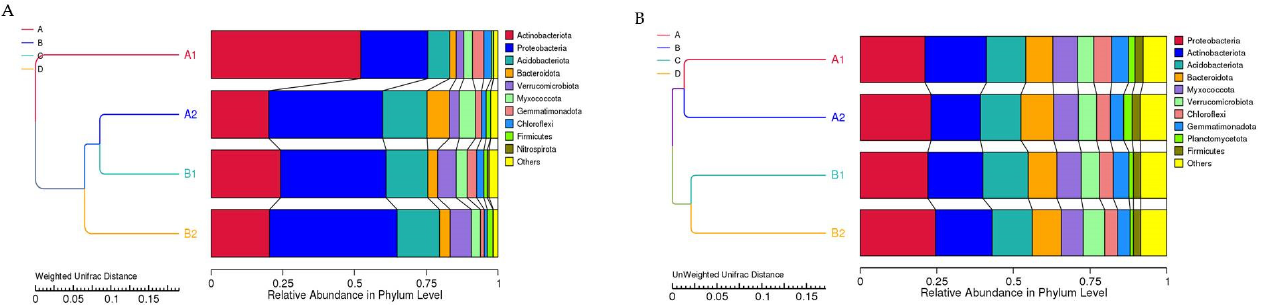
Figure 11. ( A ) UPGMA cluster tree based on Weighted Unifrac distance. ( B ) UPGMA cluster tree based on Unweighted Unifrac distance, which is plotted with UPGMA tree on the left and relative abundance in phylum map on the right (A1, thermophilic of Harmanli site; A2, mesophilic of Harmanli site; B1, mesophilic of Yasno pole site; B2, thermophilic of Yasno pole site).